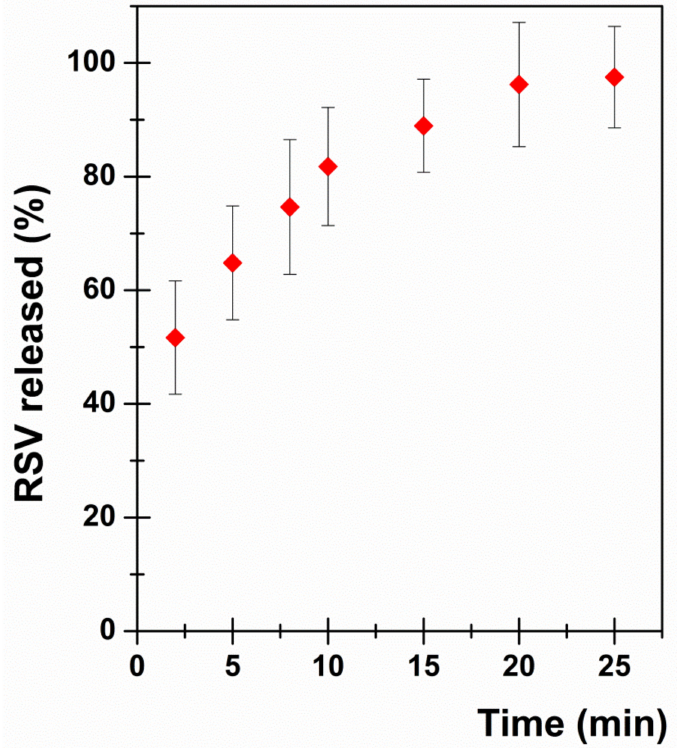
Figure 11. In vitro dissolution profile: RSV released (% of dose) as a function of incubation time (min). Results are presented as means ± SE ( n =